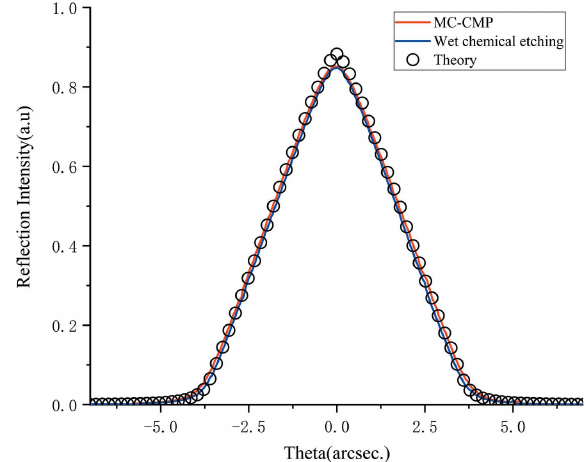
Figure 5 Comparison of the experimental and theoretical rocking curves for MC- CMP and WCE processed channel-cut crystals. The experimental data are shown as solid lines (red and blue lines correspond to MC-CMP and WCE processed channel-cut crystals, respectively). The black hollow circles represent theoretical calculation.